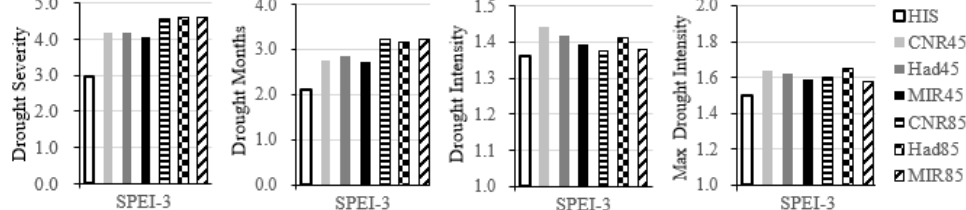
Figure 9. Comparison of multi-year average values of annual drought characteristic values for drought conditions (SPEI-3 ≤ − 1) historically (1961–2015) and in the future (2020–2098).